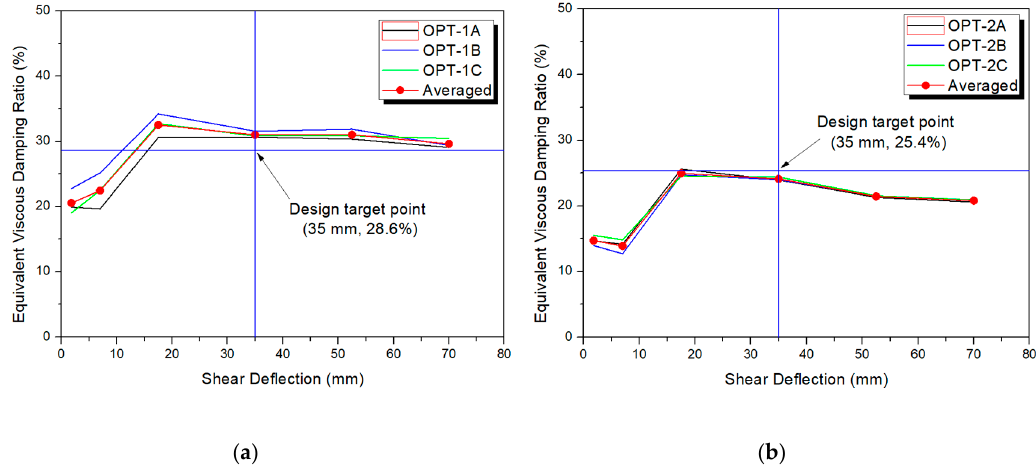
Figure 17. Determined equivalent viscous damping ratio: ( a ) OPT-1; ( b )